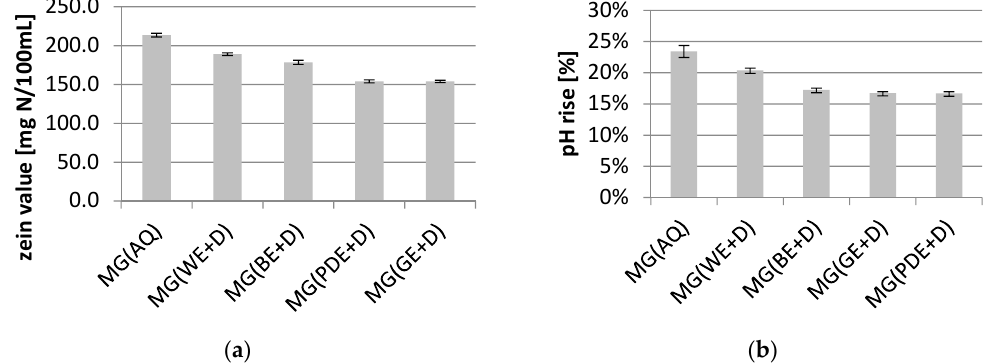
Figure 5. Zein value ( a ) and increase of pH of BSA solution ( b ) of model body wash gels, where: MG(AQ)—model gel containing water in place of extract, MG(WE+D), MG(BE+D), MG(GE+D), MG(PDE+D)—model gels containing 10% ( w / w ) of appropriate extracts. The final result was the arithmetic mean of five independent measurements.